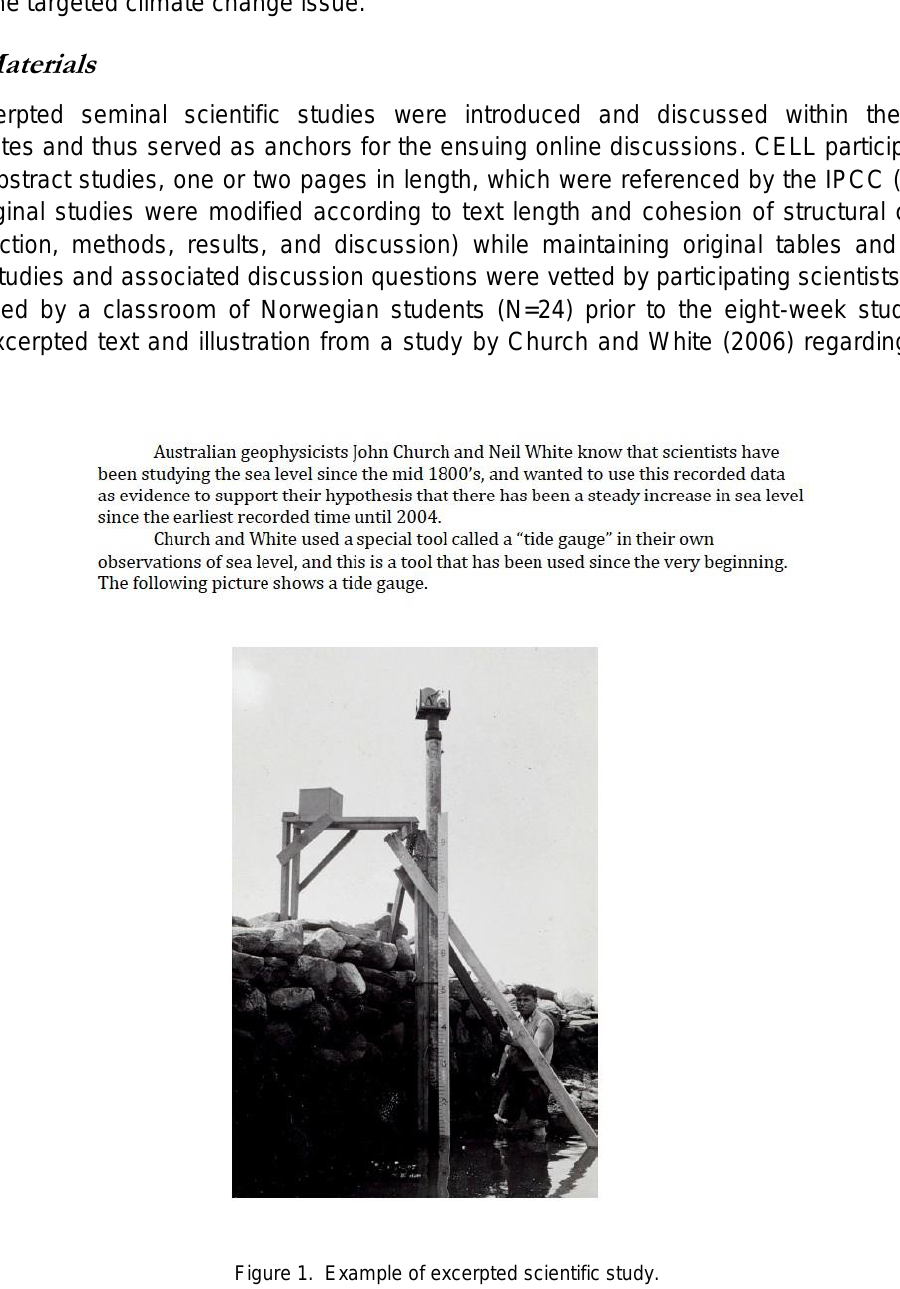
Figure 1. Example of excerpted scientific